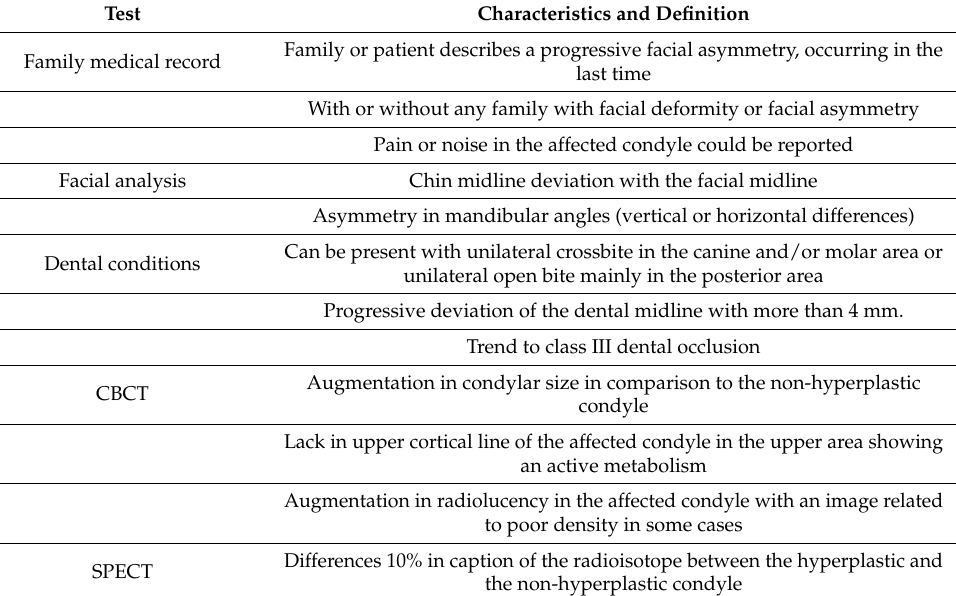
Table 1. Variables and criteria related to diagnosis in unilateral condylar hyperplasia applied to this